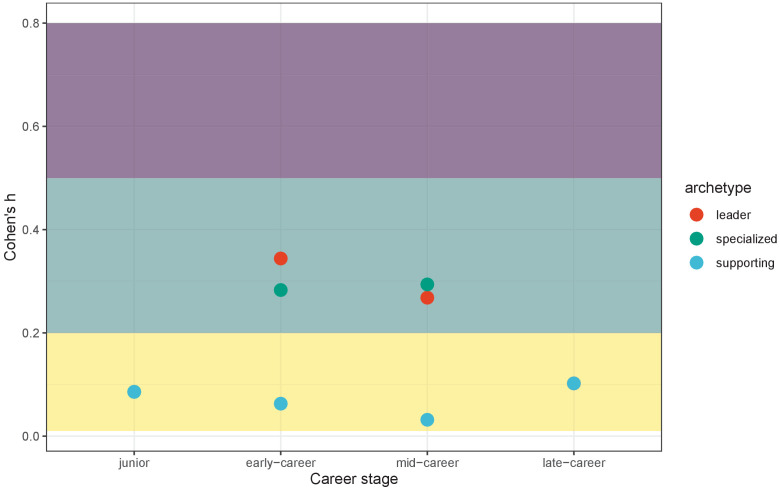
Effect sizes for proportion tests to identify differences by gender and archetype at each career stage.Colored areas provide descriptive interpretation. Yellow indicates small effect size, green indicates medium and purple indicates large effect. Values for all archetypes in junior and late-career stage are overlapping.